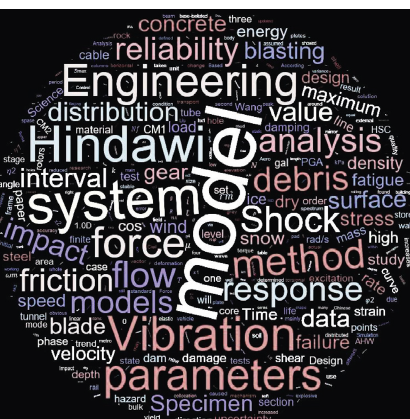
Figure 1: Word cloud from all accepted